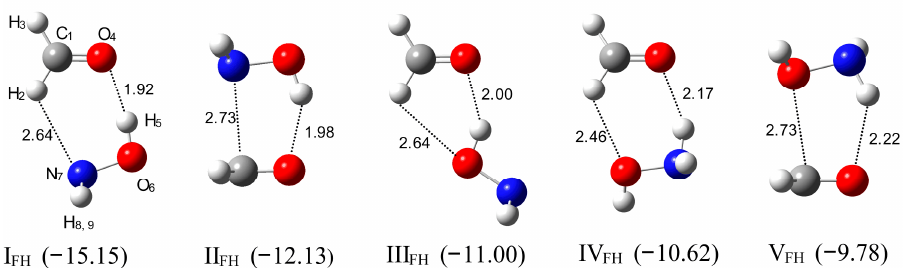
Figure 1. The optimized structures of the HCHO–NH 2 OH complexes, I FH –V FH . The ∆ E CP (ZPE)-binding energies in kJ mol − 1 are given in parentheses. The intermolecular distances are given in Å.